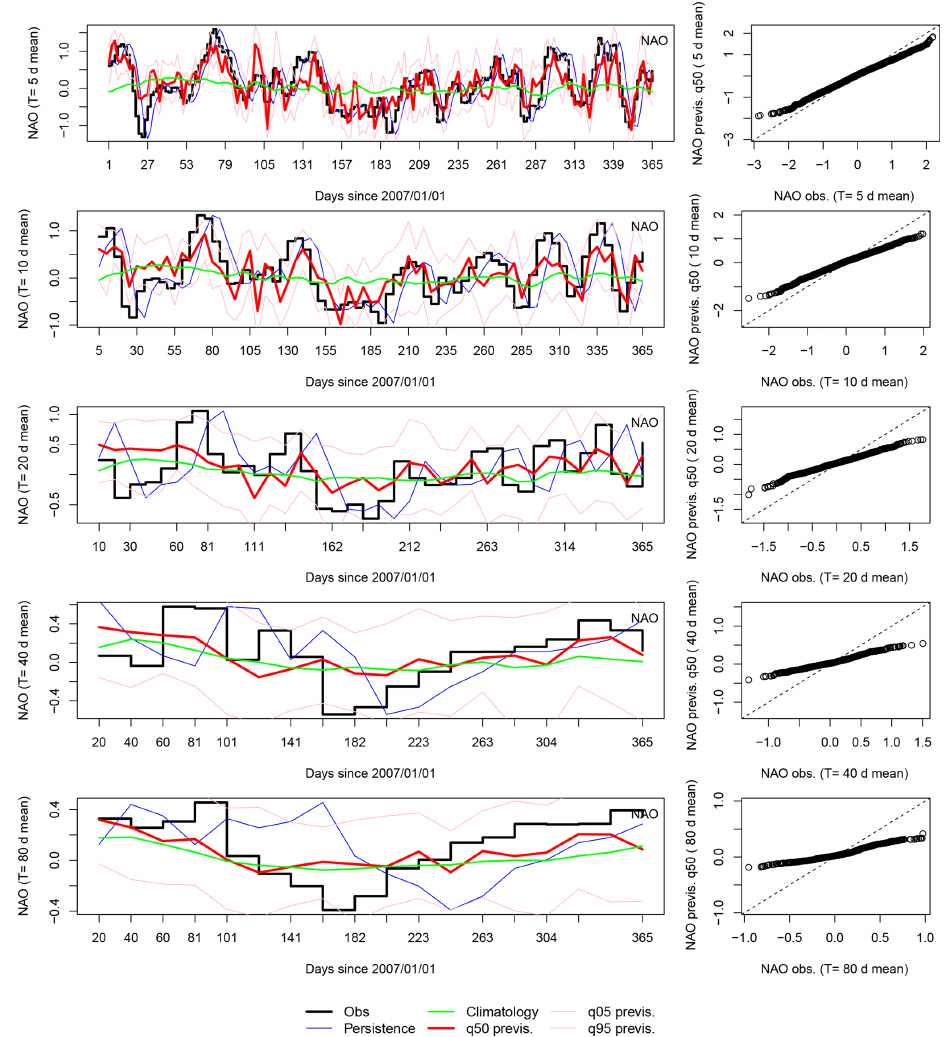
Figure 4. Left column: time series of analogue ensemble forecasts for 2007, for lead times T ∈ { 5 , 10 , 20 , 40 , 80 } days. Red lines represent the median of 100 simulations; pink lines represent the 5th and 95th quantiles of the 100-member ensemble. Right column: q − q plots of NAO forecasts versus observed values for all years in 1970–2010 for all lead times. The dotted line is the first